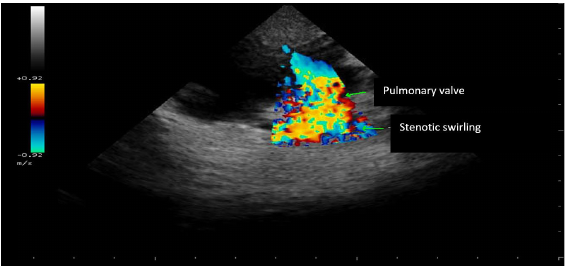
Figure 5. Doppler echocardiographic image, right parasternal window, at the right ventricular outflow tract, to the doppler study showing stenosis swirling.